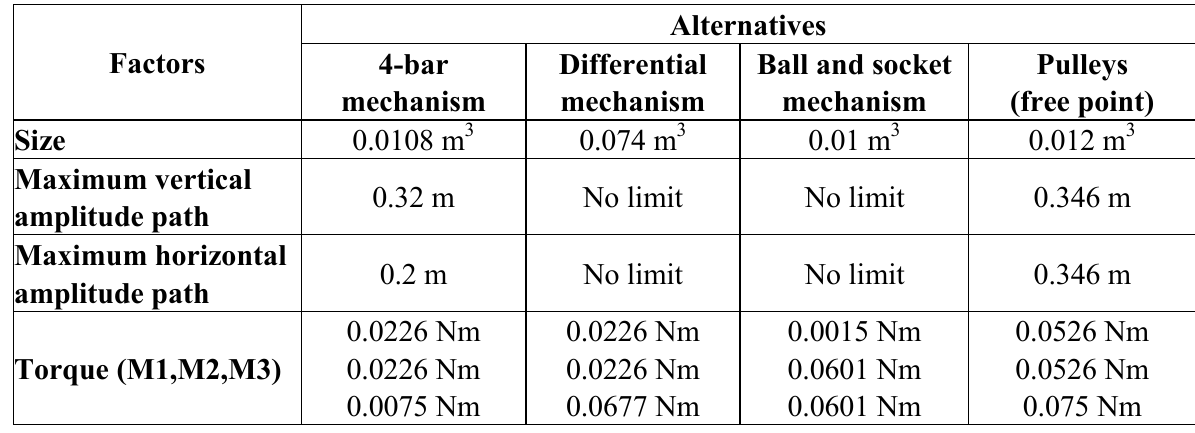
Table 1. Decision